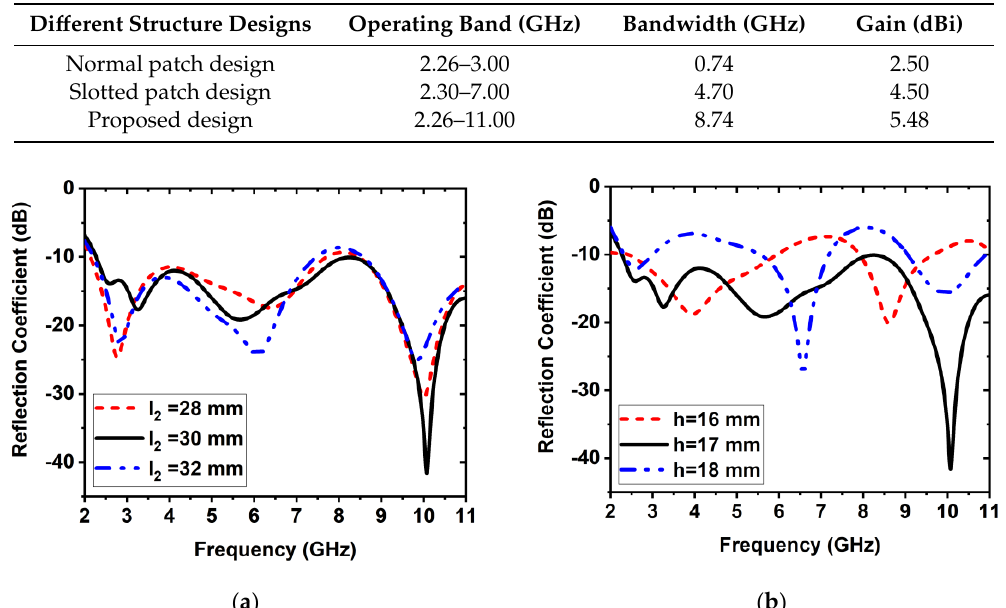
Figure 5. The effect of the reflection coefficient: ( a ) When length l 2 = 28 mm, 30 mm, and 32 mm; ( b ) Figure 5. The e ff ect of the reflection coe ffi cient: ( a ) When length l 2 = 28 mm, 30 mm, and 32 mm; When height h = 16 mm, 17 mm, and 18 mm. ( b ) When height h = 16 mm, 17 mm, and 18 Table 2. Different structure designs comparison table.